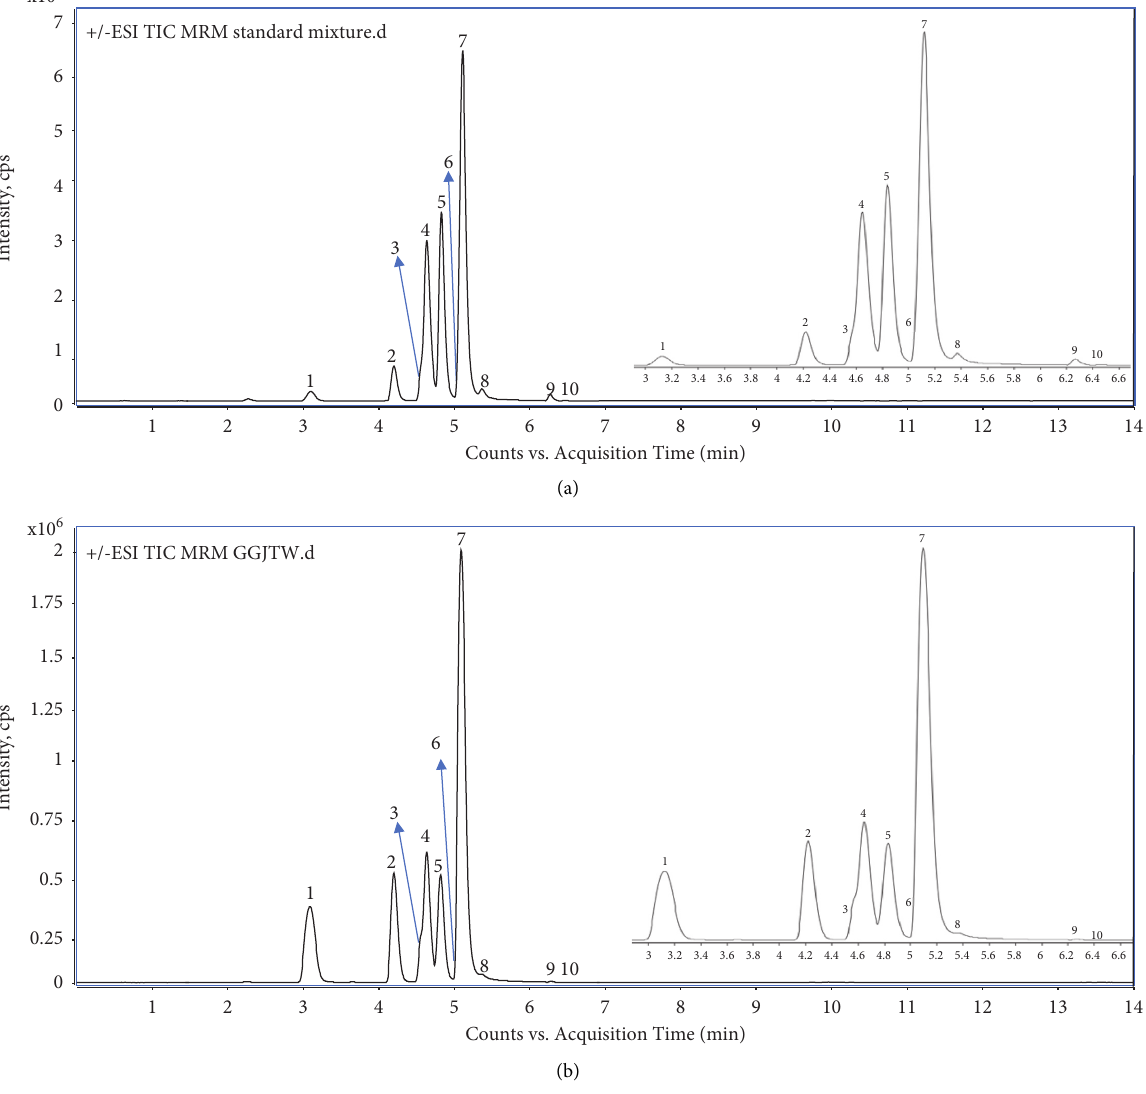
Figure 4: Representative MRM chromatograms of (a) standard mixture and (b) GGJTW extract: puerarin (1), daidzin (2), coptisine (3), epiberberine (4), jatrorrhizine (5), berberine (6), palmatine (7), coumarin (8), daidzein (9), and cinnamic acid (10).